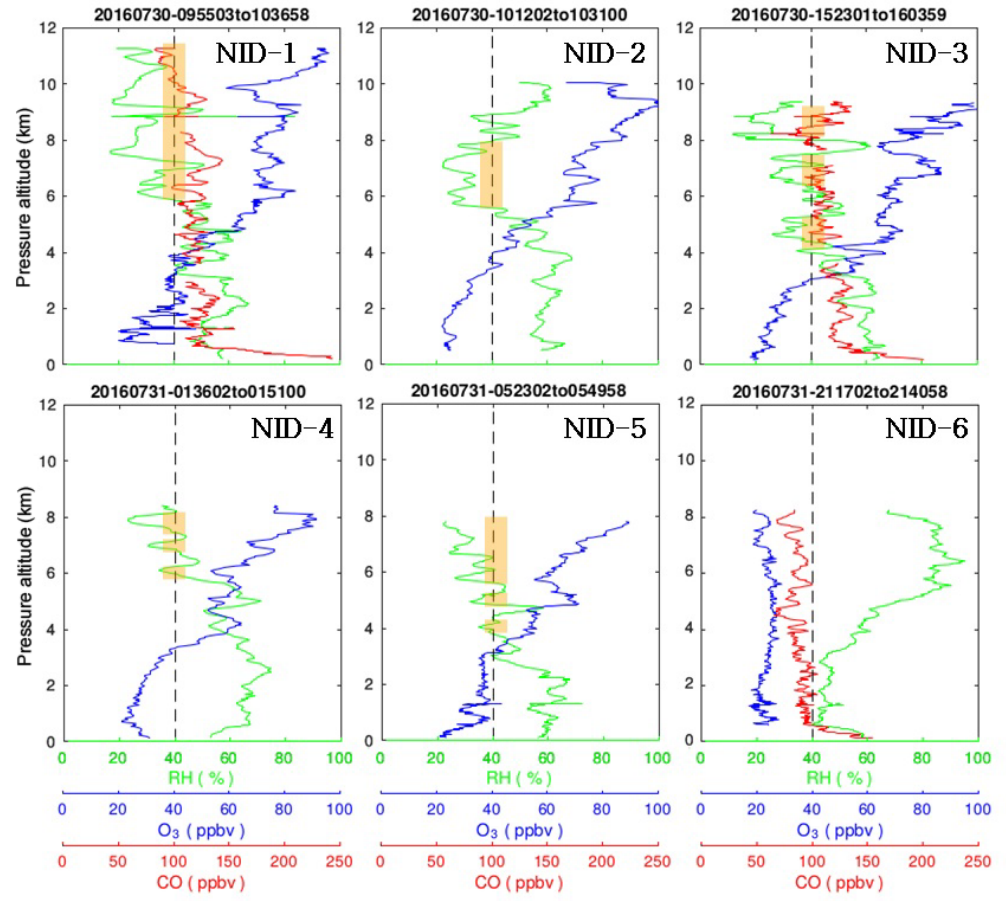
Figure 9. As in Fig. 6, except for the six take-offs from and landings to TPE of IAGOS aircraft on 30–31 July.